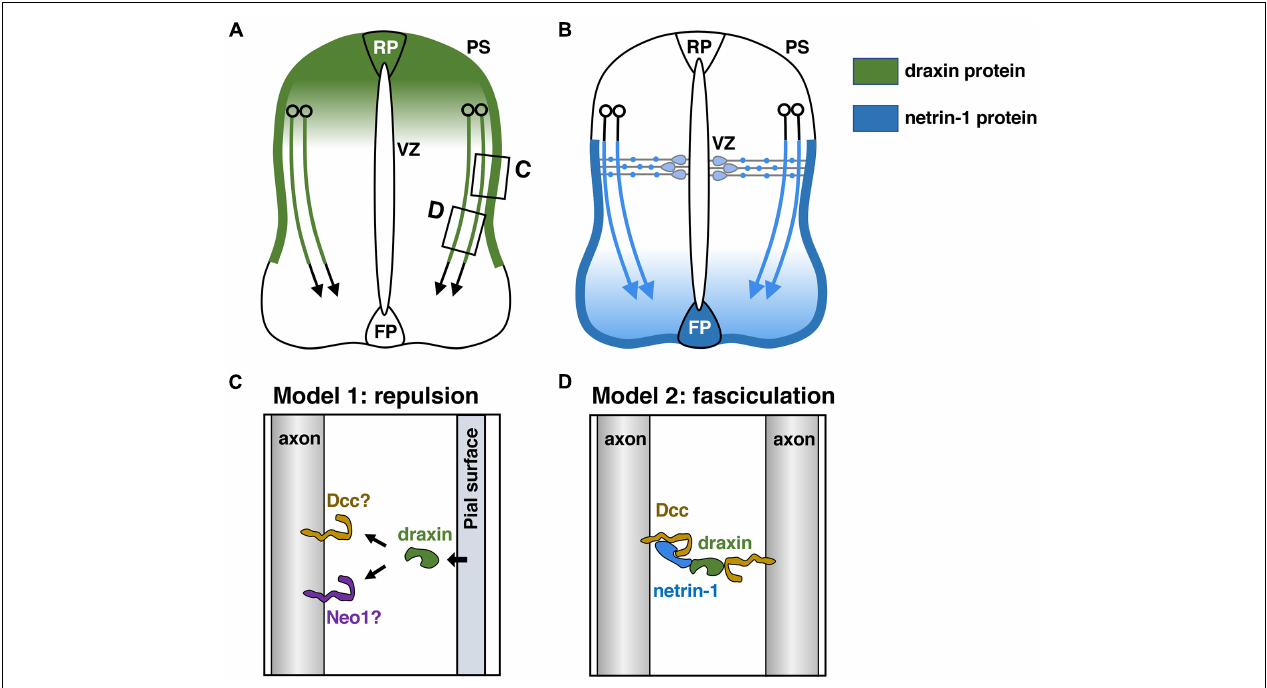
FIGURE 2 | Draxin and netrin-1 signaling in the guidance of spinal commissural axons. (A) Draxin mRNA is expressed in the dorsal spinal cord including the roof plate (RP), and its protein is deposited along the pial surface of the dorsal spinal cord and commissural axons. VZ, ventricular zone; PS, pial surface. (B) Netrin-1 produced by progenitor cells in the ventricular zone and the floor plate (FP) cells acts synergistically to guide commissural axons in the spinal cord. Note that netrin-1 is deposited along the pial surface of the ventral spinal cord and commissural axons. (C,D) Two models for draxin functions in the guidance of spinal commissural axons. The areas within the boxes in panel (A) were magnified and are shown in panels (C,D) . We have proposed that draxin on the pial surface acts as a repulsive barrier for commissural axons (C) . Liu et al. (2018) have proposed a model in which draxin mediates the fasciculation of Dcc-expressing axons by creating a Dcc-draxin-netrin-1-Dcc bridge-like configuration between two axons (D)